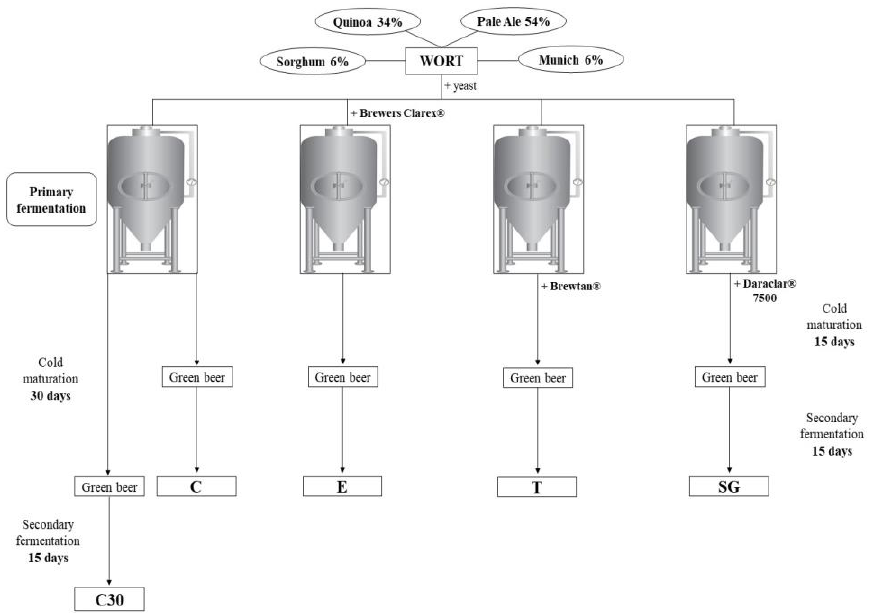
Figure 1. Schematic overview of the experimental design.